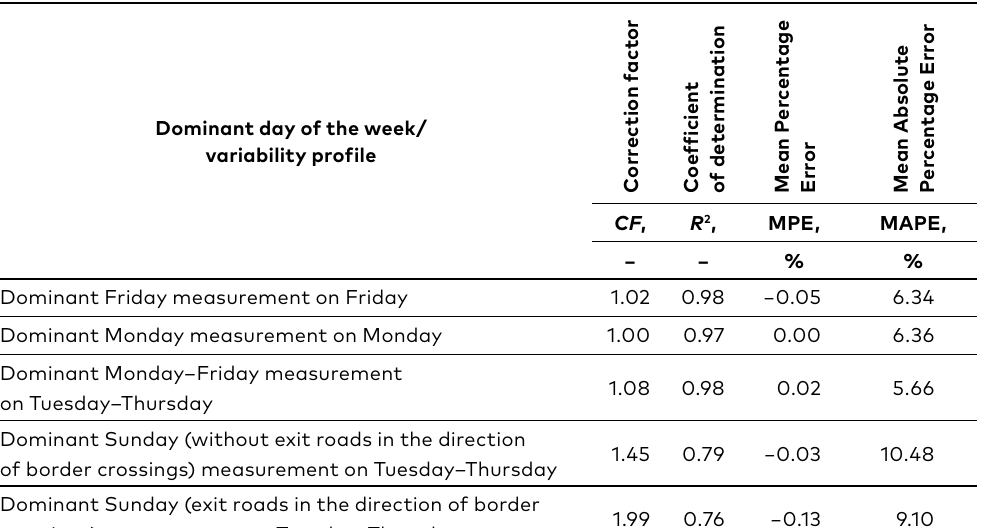
Table 3. Statistical data for estimating the Design Hourly Volume according to the correction